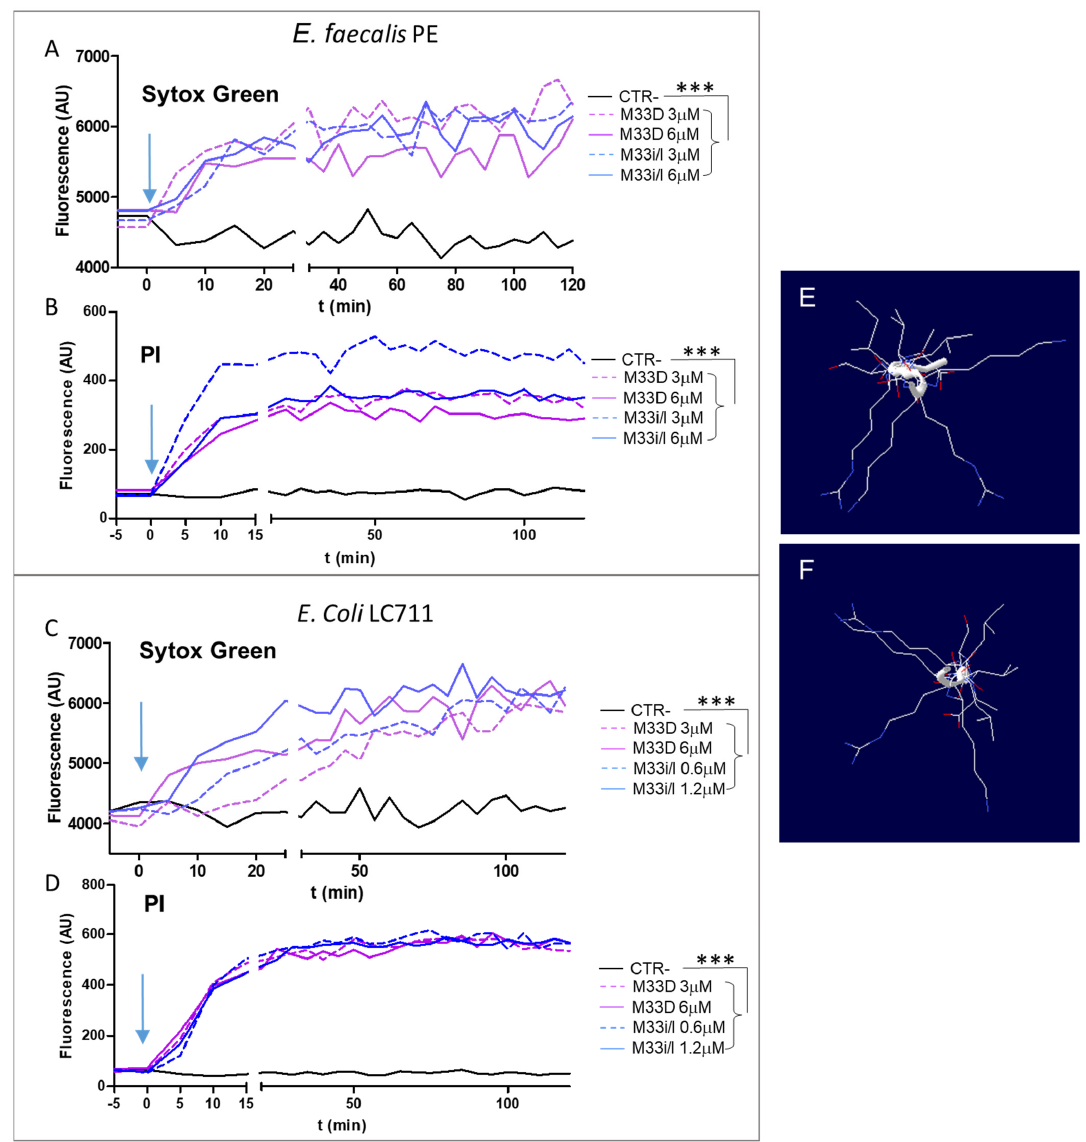
Figure 2. Observations on peptide mechanism of action. Membrane permeabilization ( A ) Sytox Green and ( B ) PI in E. faecalis PE and ( C , D ) in E. coli LC711 Experiments were performed with 10 8 CFU/mL bacteria in PBS-glucose. The blue arrow indicates the time when the peptides were added. The peptides were used at 2- and 4-fold their MIC. *** p < 0.0001 for both peptides and both concen- trations. De novo prediction of peptide tertiary structure by APPTEST for the linear analogs of M33D ( E ) and M33i/l ( F ).